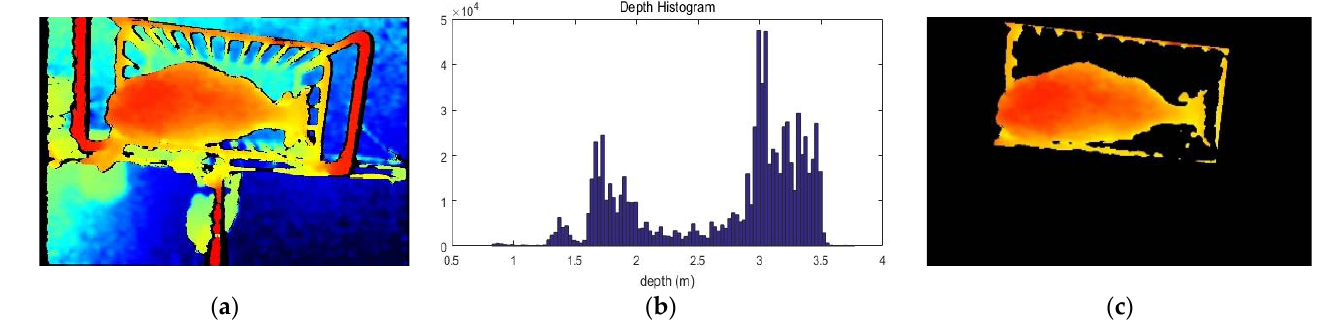
Figure 3. Segmentation process of cattle from depth image. ( a ) Depth image of cattle. ( b ) Histogram of depth image. ( c ) Segmentation result of cattle.